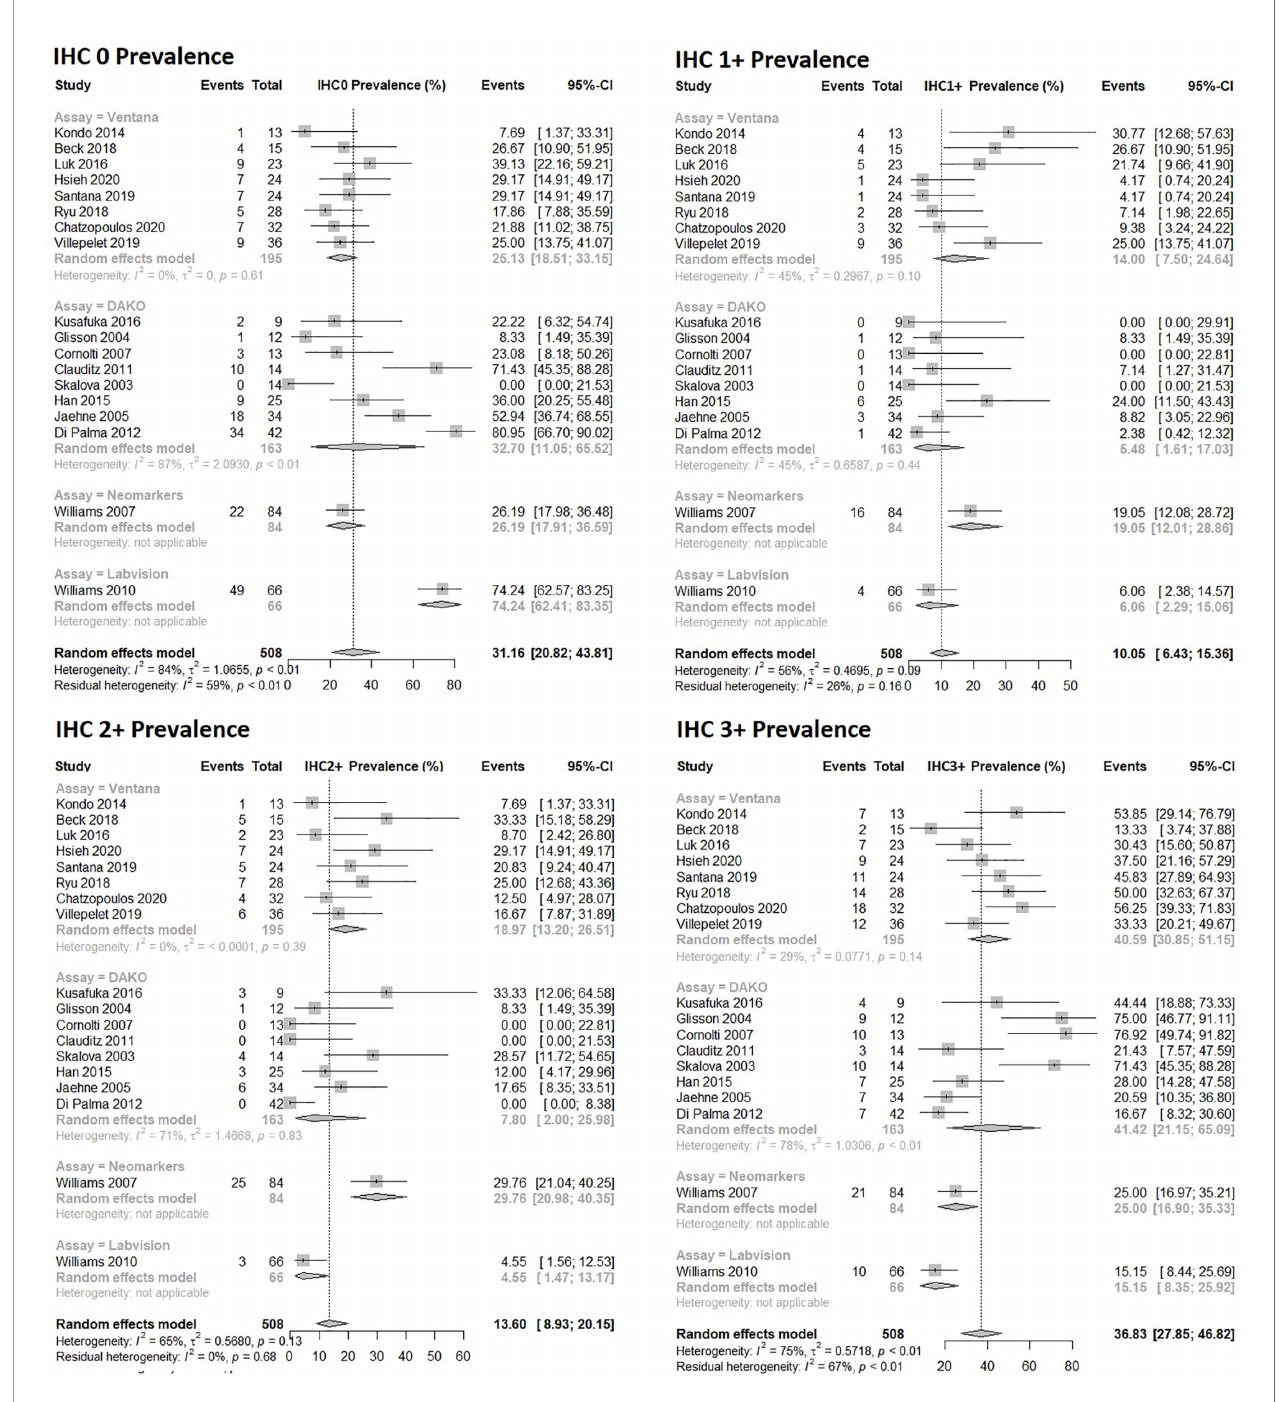
FIGURE 2 | Forrest plot of prevalence estimates for HER2 protein expression assessed by IHC in salivary duct